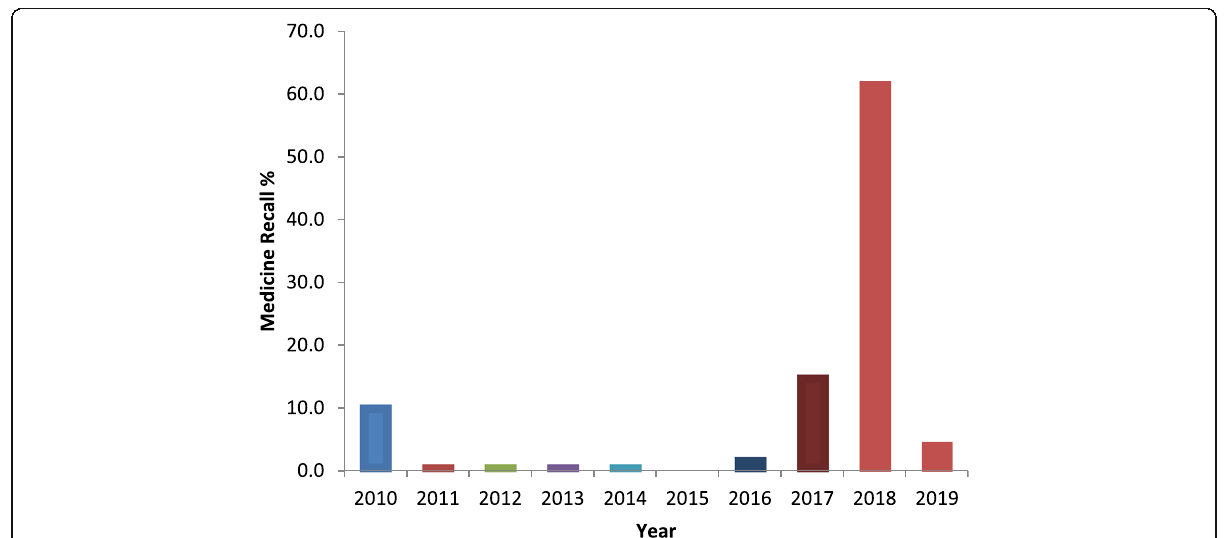
Fig. 1 Percentage of recalled medicines reported by Saudi FDA (January 2010 – January